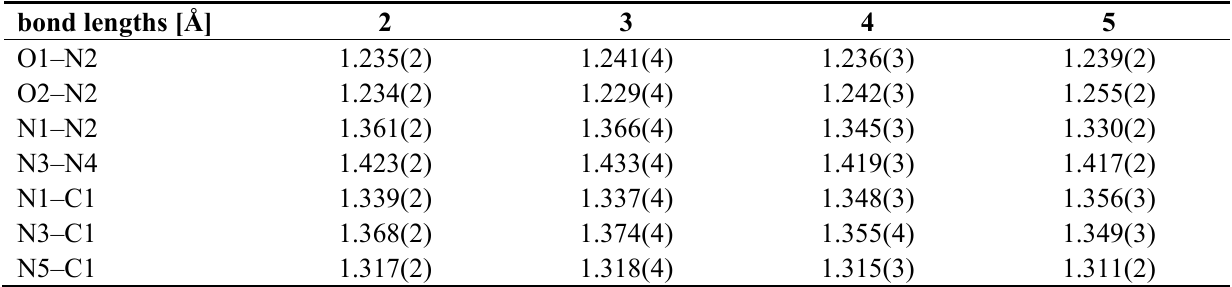
Table 2. Selected bond lengths [Å] of compounds 2 – 5